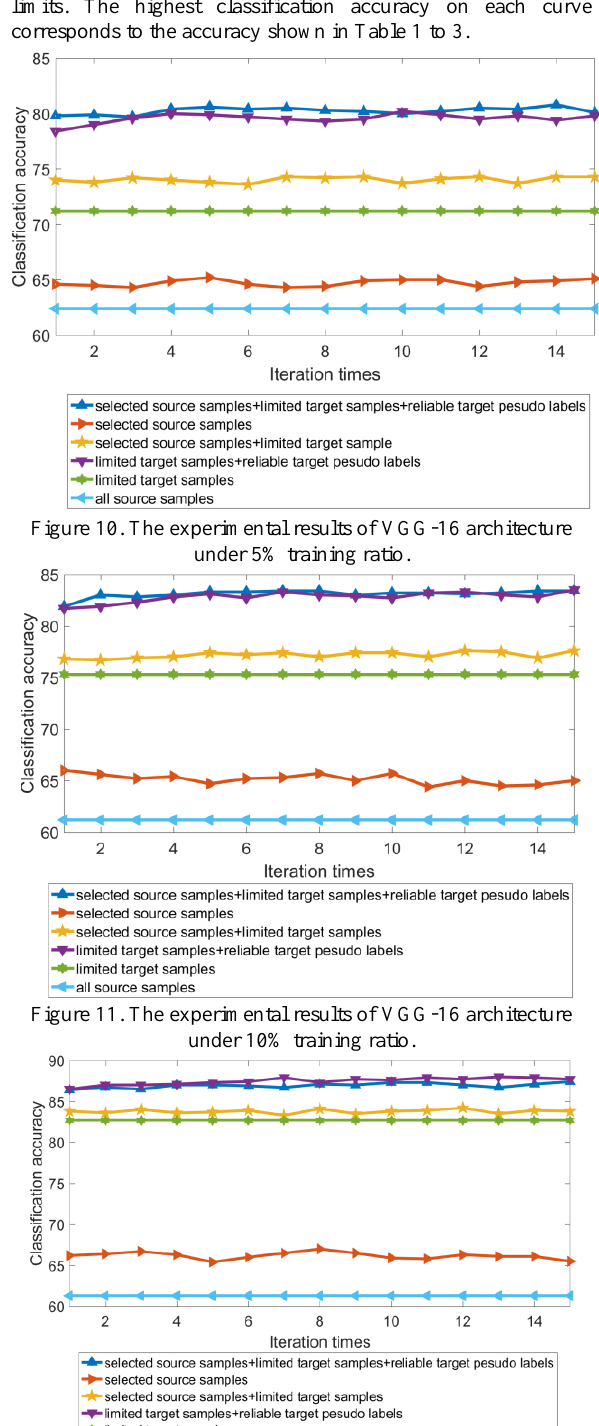
Figure 12. The experimental results of VGG-16 architecture with 20% training